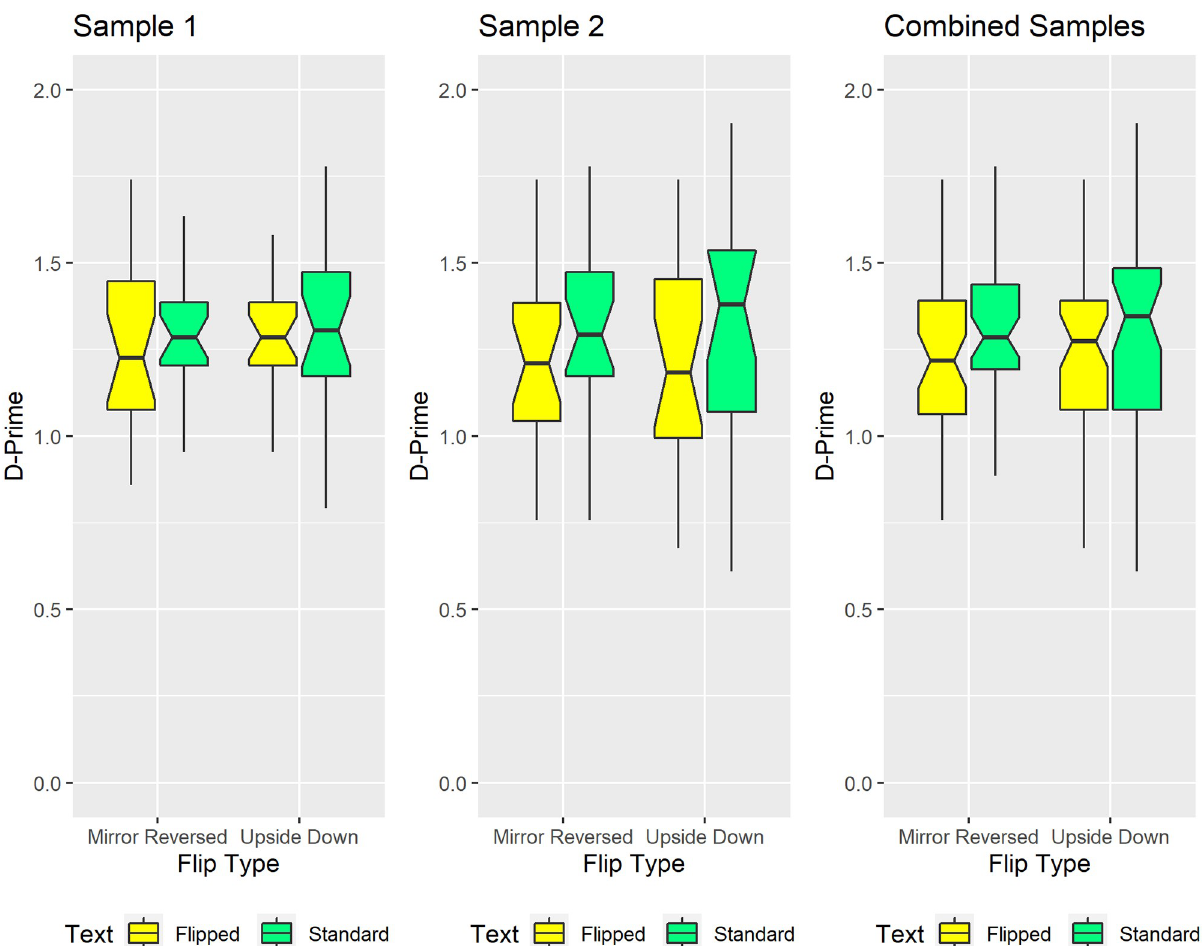
Fig 5. The precision of sentence length judgments. Among the 44 participants in Sample 1, 22 judged mirror-reversed and standard text, and 22 judged upside-down and standard text. Sample 2 (n = 44) was a direct methodological replication of Sample 1. In each sample, flipped text (yellow boxes) slightly impaired the precision of sentence-length judgments relative to standard text (green boxes). The combined samples revealed a statistically significant albeit small inversion effect for sentence length judgments. The upper and lower edges of each colored box respectively reflect the 75th and 25th percentiles, and the central black horizontal line marks the median. The notches within each box extend away from the median by 1.58 � Interquartile Range / sqrt(n), and approximate 95% confidence intervals for comparing medians (98, 99). Whiskers extend to the most extreme empirically observed value no further than ± 1.5 � interquartile range from the 75th and 25th percentiles.